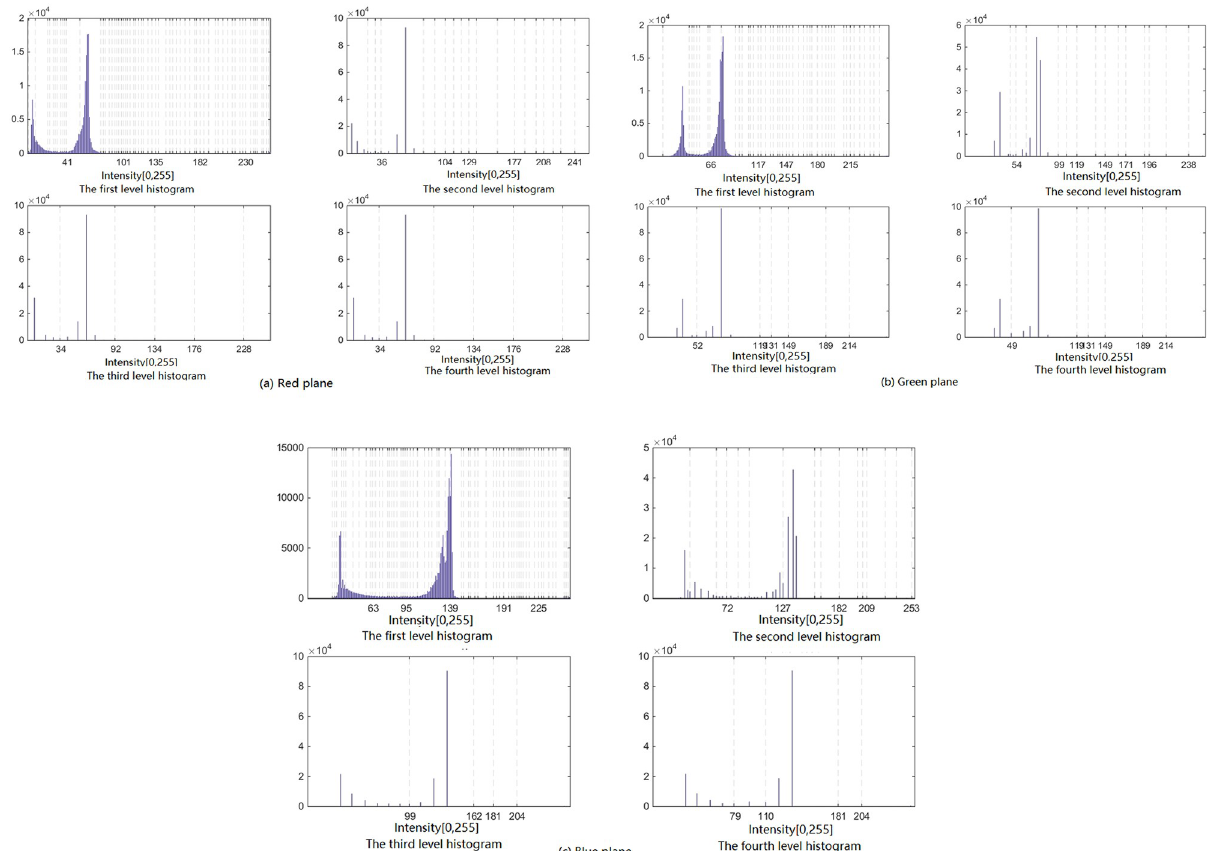
Fig 2. Hierarchical-histogram of each plane of R, G, and B of the image Moon obtained by